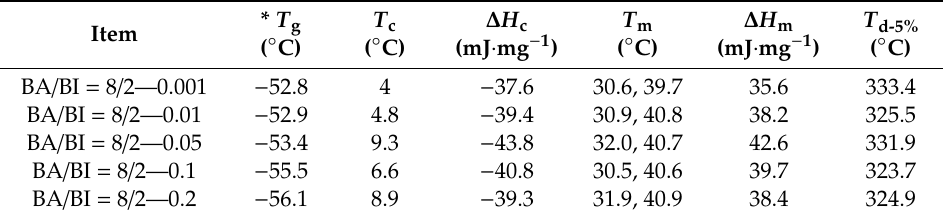
Table 6. Thermal properties of the PBABI copolyesters at di ff erent concentrations of